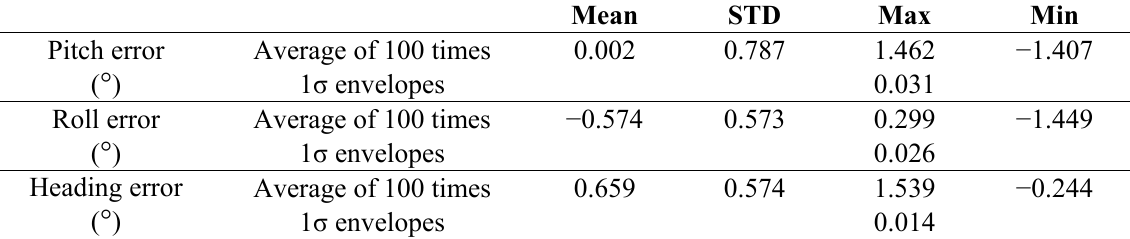
Table 2. Statistics of Figure